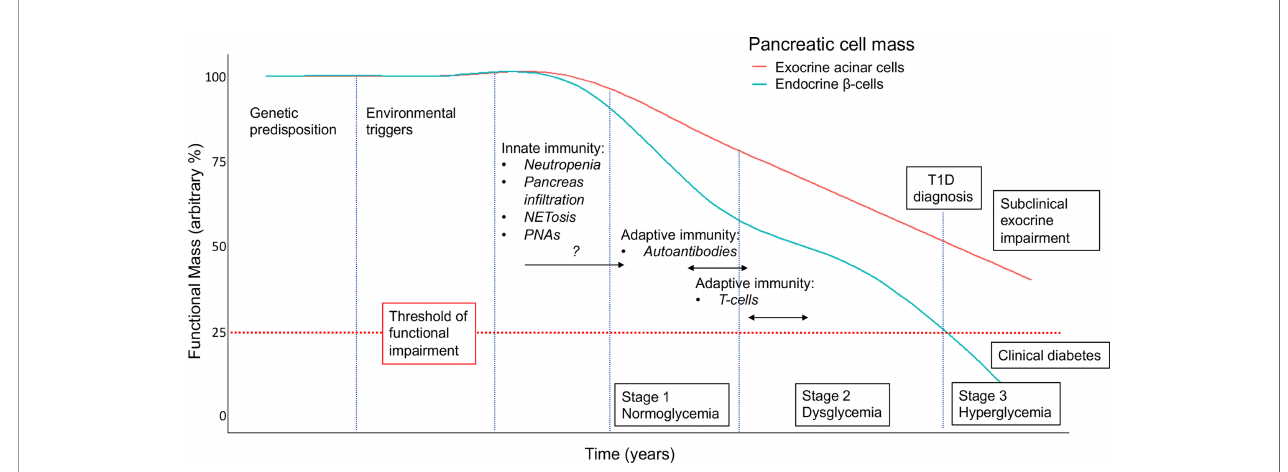
FIGURE 2 | Proposed model for the contribution of neutrophils/NETs to the natural history of the decline in pancreatic endocrine (i.e., beta cell) and exocrine (acinar) function in T1D. Staging, as de fi ned in (74), with modi fi cations and incorporating assumptions based on available clinical and preclinical data. An arbitrary threshold is set at 25% to indicate functional pancreatic insuf fi ciency. NETosis, neutrophils releasing extracellular traps; PNAs, platelet-neutrophil